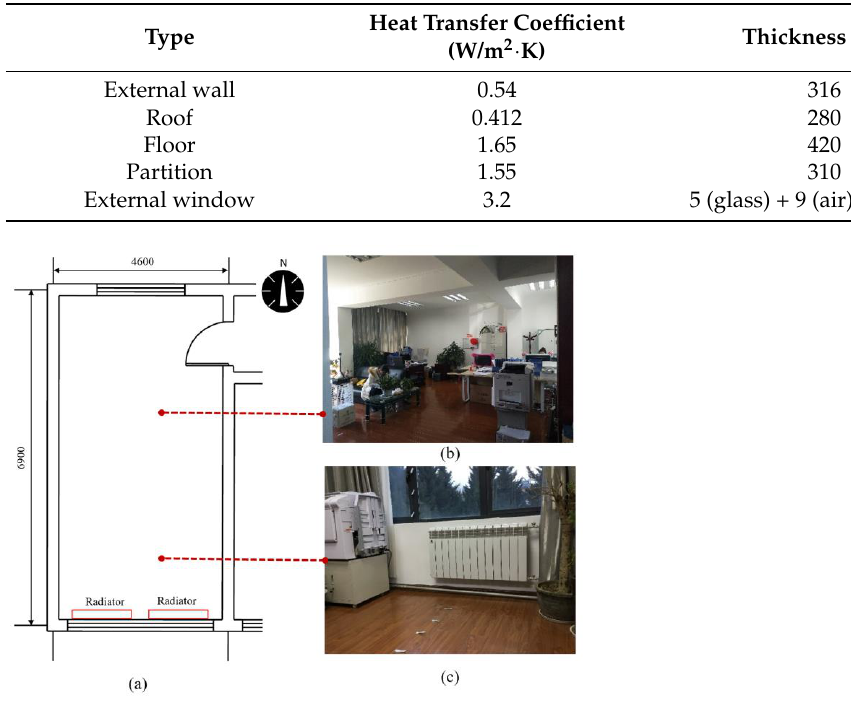
Figure 3. The office room of the building selected: ( a ) the general layout of the office room; ( b ) the state of the office room; ( c ) the south windows and radiator. Table 1. The window-to-wall ratio of the office building.